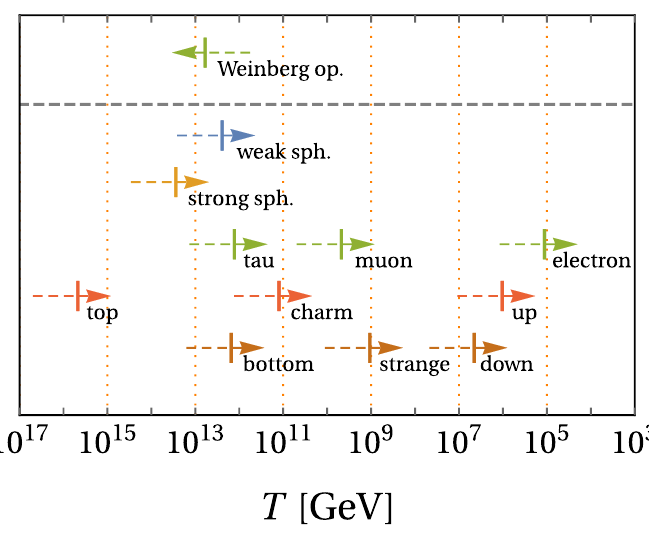
Figure 2 . Equilibration temperatures for individual SM interactions, T (cid:11) . Each dashed line in- dicates the range from 10 T (cid:11) to T (cid:11) , within which one can expect non-trivial e(cid:11)ects due to partial equilibration. The solid arrows (starting from the vertical lines) indicate that the interactions are in equilibrium for T < T (cid:11) . At the top of the (cid:12)gure, we also show the decoupling temperature of lepton number violating interaction via the dimension (cid:12)ve Weinberg operator as a vertical line, above which it is in equilibrium [see eq. (5.5))]. The dashed line starts from T (cid:11) = 10 in this case, as this interaction is weaker for lower